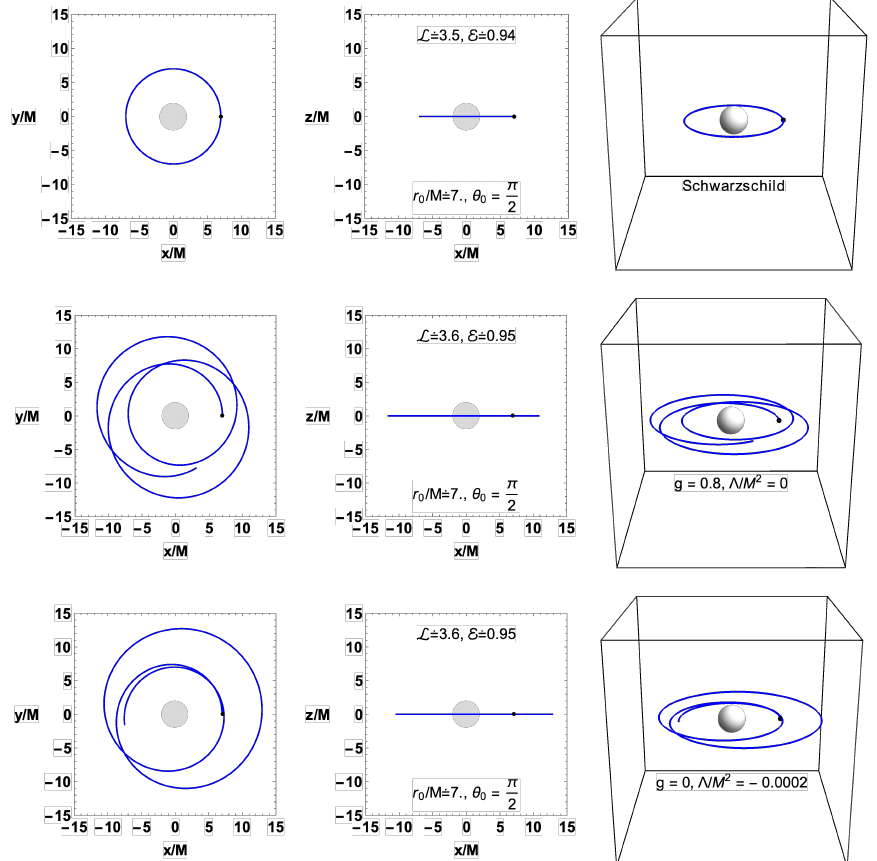
Figure 2. Test particle trajectories for fixed values of g and Λ . The first line corresponds to the Schwarzschild black hole. The second line corresponds to the magnetically charged black hole. The bottom line is for black hole in Anti-de Sitter spacetime.